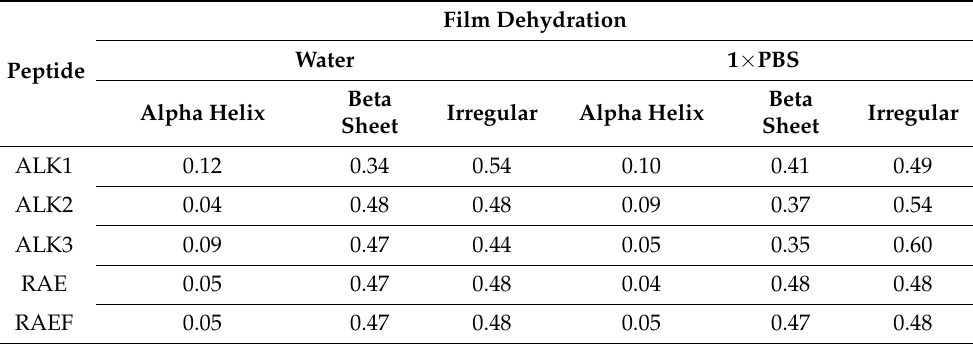
Table 2. Peptides were prepared using the film dehydration method and resuspended with water or PBS. Circular dichroism spectra were evaluated from 190–300 nm. Spectra were analyzed on DichroWeb [22,23] using the K2D method to estimate secondary structure. Film Dehydration Water 1 × PBS Peptide Alpha